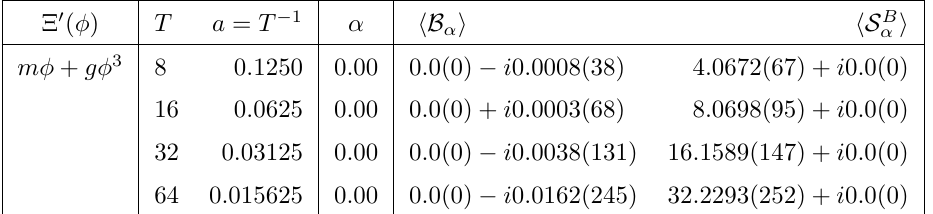
for SUSY anhar- α